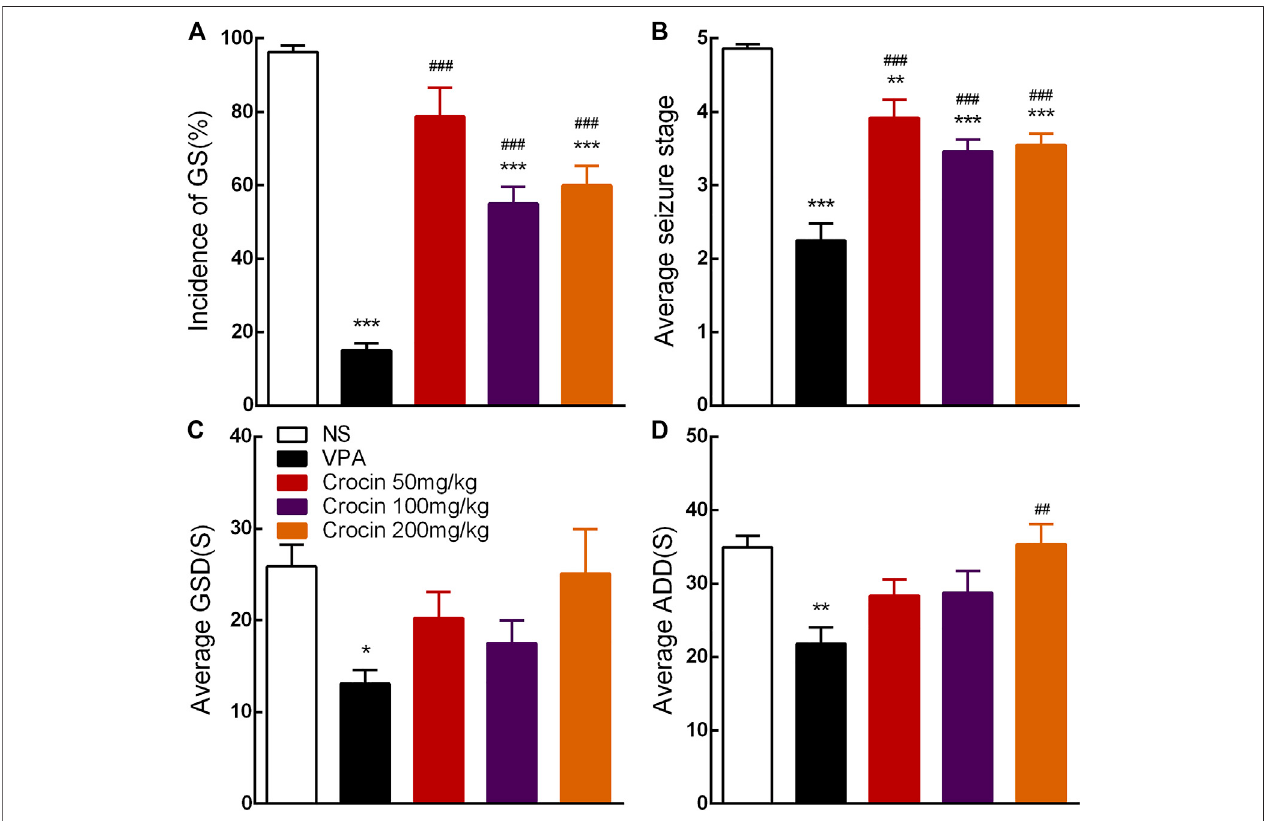
FIGURE3| EffectsofcrocinontheincidenceofGSandseizureseverityinfullykindledmice( n =8foreachgroup,x (cid:1) ±S.E.M.). (A) MeanincidenceofGS, (B) average seizure stage, (C) average GSD and (D) average ADD during 10 days. GS, generalized seizure, GSD, generalized seizure duration, ADD, afterdischarge duration; NS, normal saline; VPA, sodium valproate. Values are from 3 independent experiments. * p < 0.05, ** p < 0.01, *** p < 0.001, compared with NS group; ## p < 0.01, ### p < 0.001, compared with VPA group. One-way ANOVA was used for (B – D) , followed by Tukey ’ s t-test. The χ 2 test was used for (A)